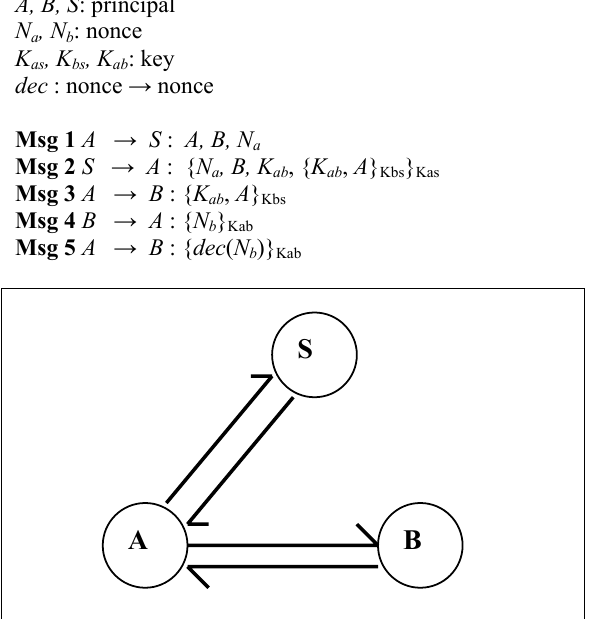
Fig. 1: NSSK Protocol: Alice(A) , Bob(B) and Server(S) A , B and S are three principals Alice , Bob and Server respectively. N a and N b are two nonces generated by A and B respectively. K as and K bs are two shared-keys used for communication between Alice and Server , and Bob and Server respectively. These two keys exist in advance to establish the trust with Server before the actual run of is generated by Server to establish trust protocol. Key K ab between Alice and Bob . de c is a decrement function which is used to performs decrement operation on